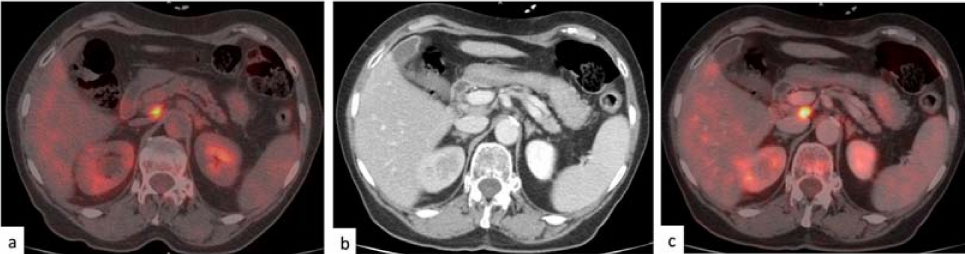
Figure 2. Concordant findings on positron emission tomography/low-dose computed tomography (PET/ldCT) and PET/contrast enhanced (ce)CT. An inter-aortocaval lymph node, with an intensive focal fluorodeoxyglucose (FDG) uptake, is noted on the PET/ldCT ( a ) on the ceCT part ( b ) and the PET/ceCT ( c ). Most lymph node and peritoneal lesions were classified concordantly by the two imaging methods.